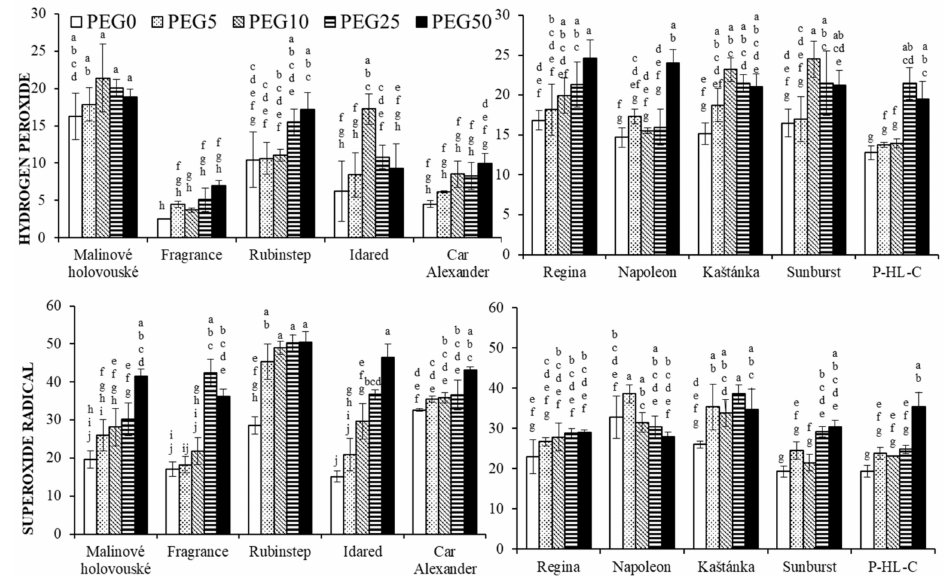
Figure 4. Effect of different concentration of PEG-6000on content of hydrogen peroxide ( µ mol g − 1 FW) and superoxide radicals ( µ g g − 1 FW) in in vitro culture of apple and cherry cultivars. Error bars represent means ± SDs (n = 3). Values within column, followed by the same letter(s), are not significantly di ff erent according to Tukey’s test ( p <